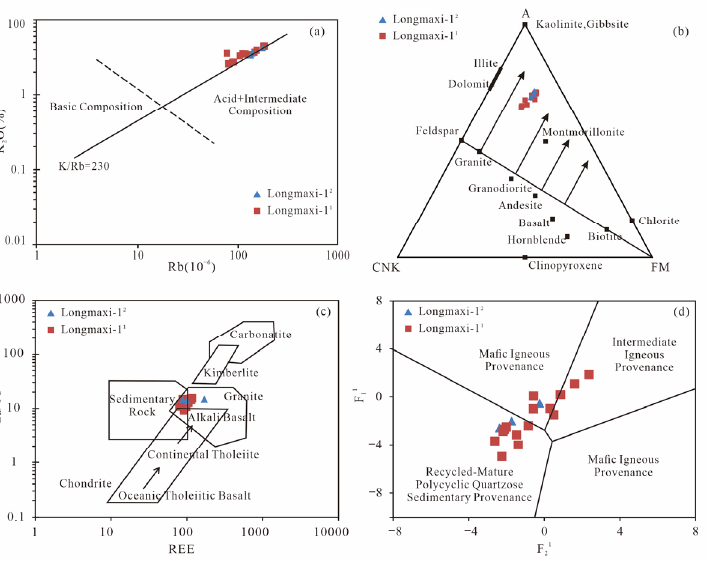
Figure 7. Provenance discrimination diagram in Longmaxi-1 black shales. ( a ) F1 ′ -F2 discrimination function diagram [72]; ( b ) REE-La/Yb [73]; ( c ) Rb-K 2 O [74]; ( d ) A-CNK-FM